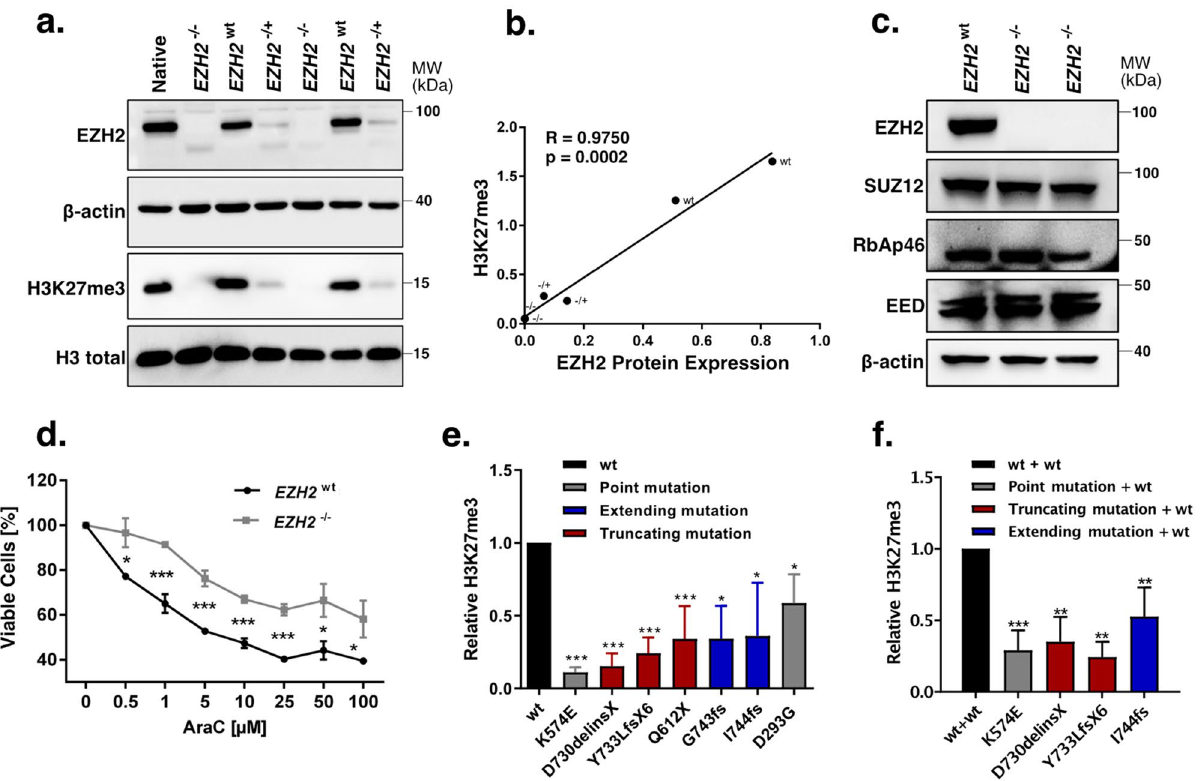
Figure 3. Evaluation of EZH2 mutations found in AML patients at diagnosis. (a) Comparison of EZH2 expression and global H3K27me3 between EZH2 −/− , EZH2 +/− and EZH2 wt sc clones in 293T cells. MW, molecular weight. β-actin and H3 total, loading controls. (b) Correlation between EZH2 protein expression and global H3K27me3 in 293T sc clones. Pearson’s correlation. (c) Immunoblot for EZH2, SUZ12, RbAP46 and EED expression in 293T/ EZH2 −/− sc clones. MW, molecular weight; β-actin, loading control. (d) AraC resistance in one 293T/ EZH2 −/− and one 293T/ EZH2 wt sc clone. Cells were treated for 72 h with different concentrations of AraC. Viable cells relative to untreated control. (e) H3K27me3 levels after re-expression of seven EZH2 mutations, detected in patient diagnosis samples. Colours referring to protein structural changes caused by the mutation. 293T/ EZH2 −/− cells were transfected transiently with EZH2 constructs 72 h before protein isolation, and global H3K27me3 was evaluated by immunoblot. Values relative to the wild type. (f) H3K27me3 levels after re-expression of four EZH2 mutants in combination with wild type EZH2 . 293T/ EZH2 −/− cells were transfected transiently with EZH2 wildtype and EZH2 mutant constructs 72 h before protein isolation. Values relative to the wild type. Unpaired, two-tailed Student’s t-test; * p < 0.05; ** p < 0.01; *** p < 0.001. Error bars indicate mean ± s.d of at least three independent